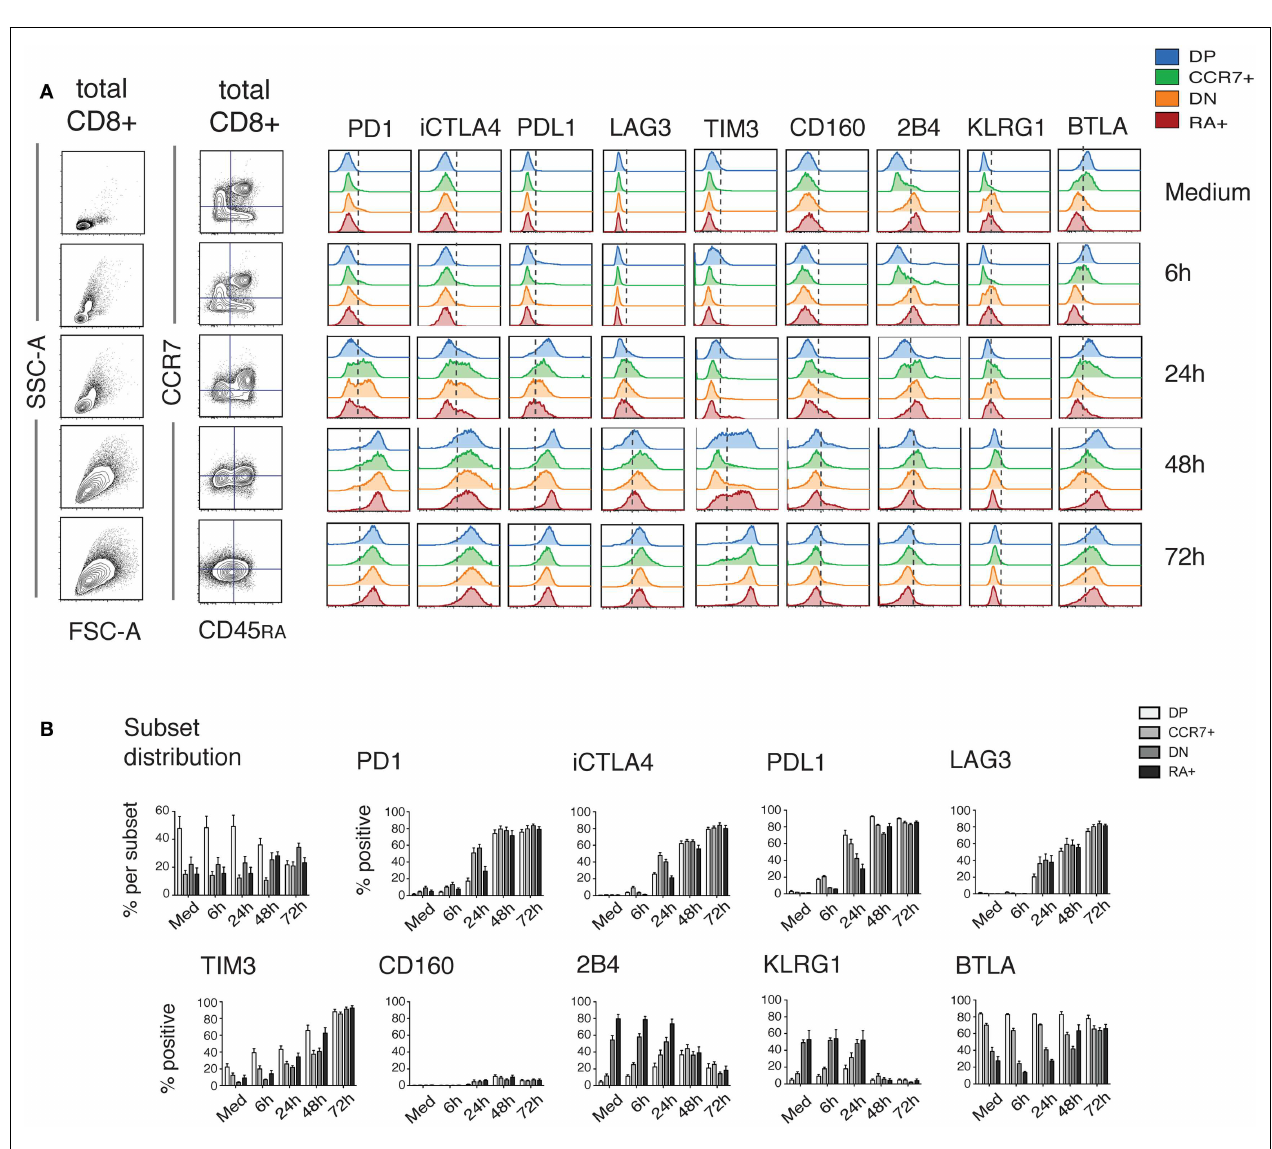
during the development of an activated blasting population, we used a constant quadrant gating, based on the medium sample, for CCR7 and CD45RA. Despite the fact that the gating is obsolete by 72h, this highlights the development of a homogeneous blast expressing various iRs. One representative example is shown. (B) . Quantification showing the percentage positive cells for each iR ( N =